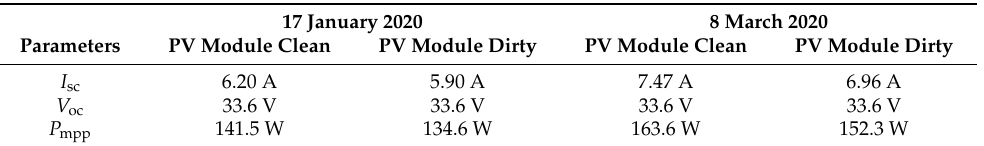
Figure 8. I–V curves ( left ) and power–voltage curves ( right ) for both of the PV modules measured at 12:00 local time on two different days. Horizontal global irradiance and back PV surface temperature are also provided. Table 2. Electrical data derived from the I–V curves corresponding to the PV modules for the two instants